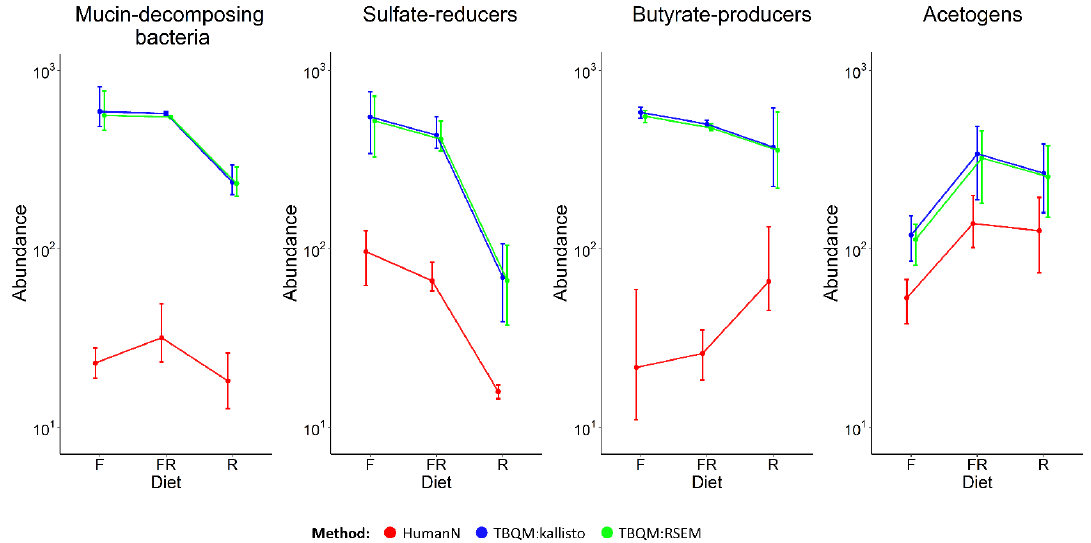
Figure 4. Comparison of TPM values of functional groups for the TBQM (with Kallisto and with RSEM) and CPM values for HumanN. F – fiber-free diet, R – fiber-rich diet, FR – alteration between fiber-free and fiber-rich